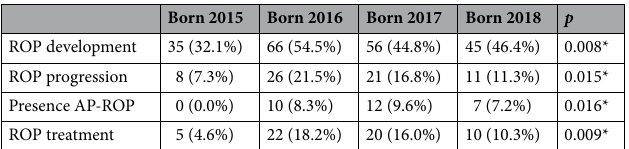
Table 2. ROP development and progression, AP-ROP and treatment from 2015 to 2018. *p < 0.005.